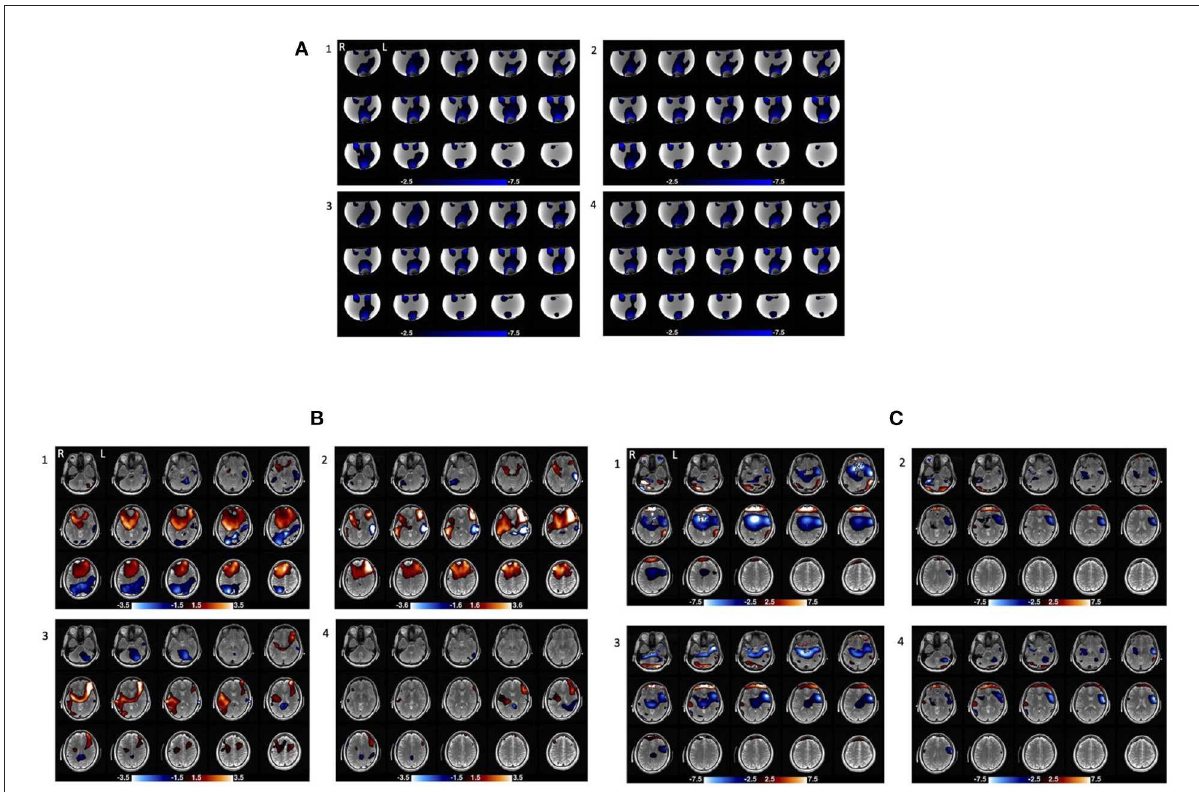
FIGURE5 Current distribution maps in four consecutive stimulation scans (repeated with no change) in the phantom and one of human subjects. (A) Current distribution maps across the four consecutive stimulation scans in the phantom. (B) Magnetic field maps across the four consecutive stimulation scans in subject 10 . The areas with red and blue gradient represent positive and negative polarity, respectively. (C) Current distribution maps across the four consecutive stimulation scans in subject 10 . The blue area shows Right to Left current (J x ) flow (the primary direction) and the red area shows Left to Right current (J x ) flow which may be an artifact of boundary conditions at the edge of the brain near the frontal orbital region where susceptibility changes